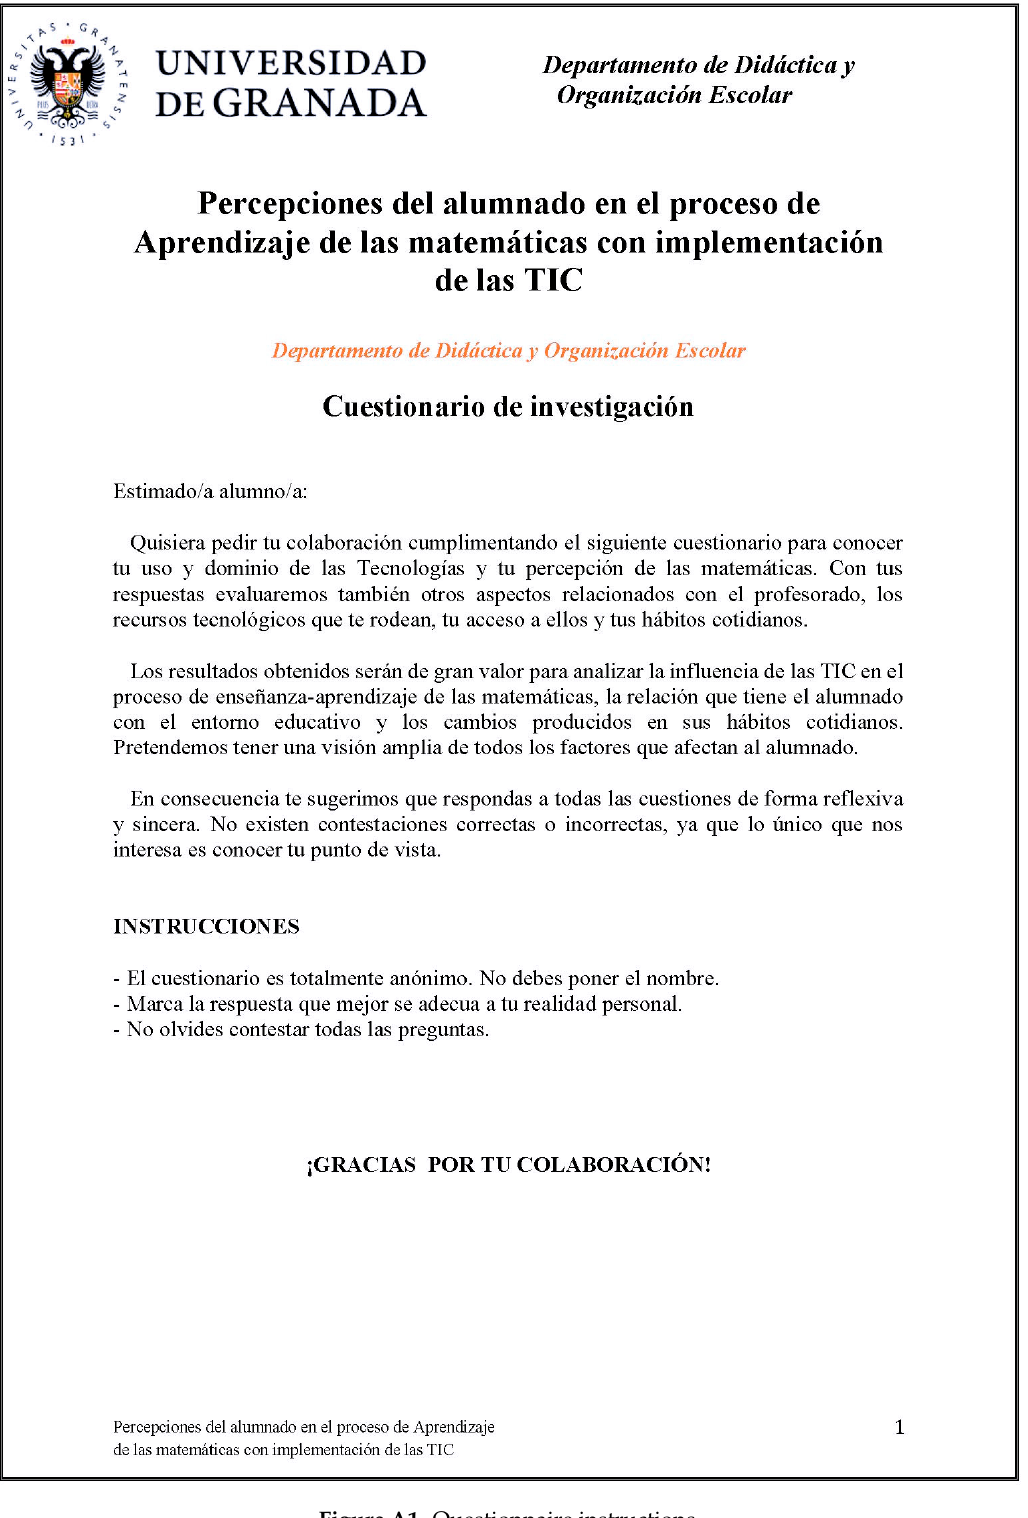
Figure A1. Questionnaire instructions.